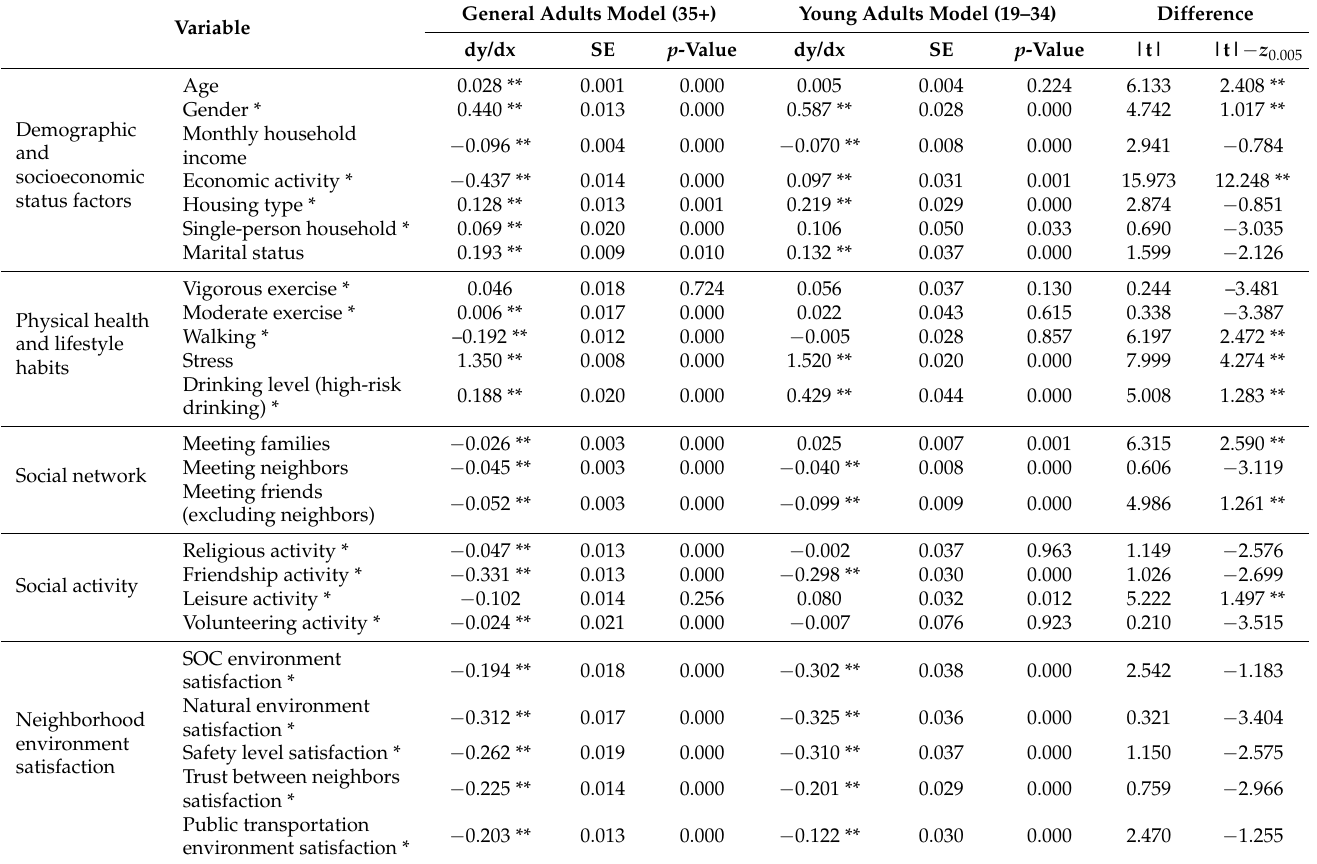
Table 5. Marginal effects in the Tobit model: comparing the general adult and young adult